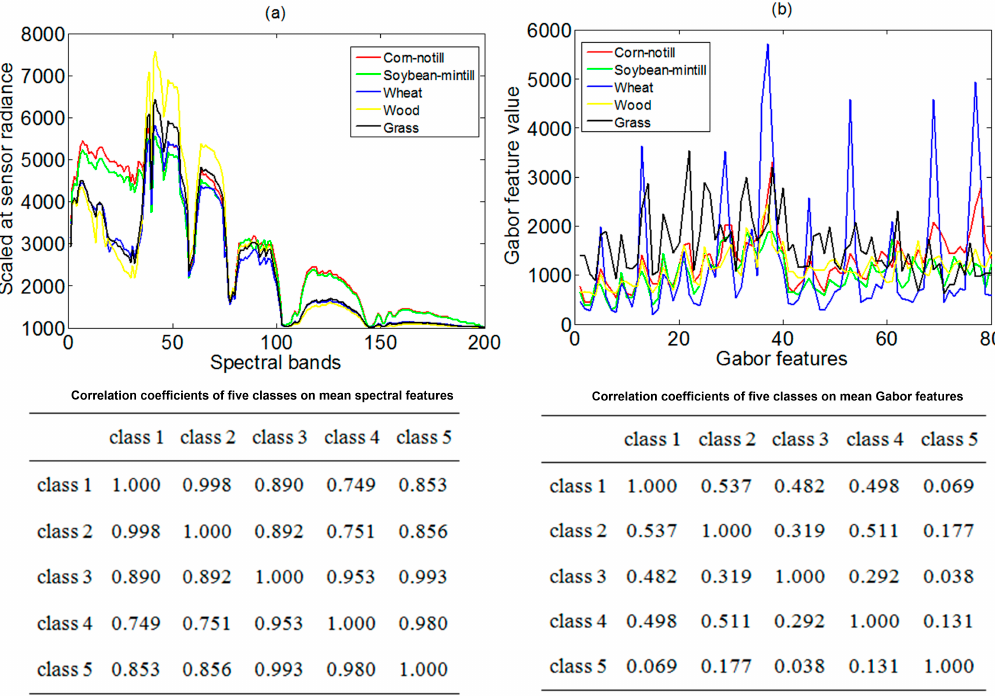
Figure 5. Mean spectra ( a ) and mean Gabor feature curves ( b ) for five classes investigated in the paper, and the corresponding correlation coefficient tables based on data set 2.